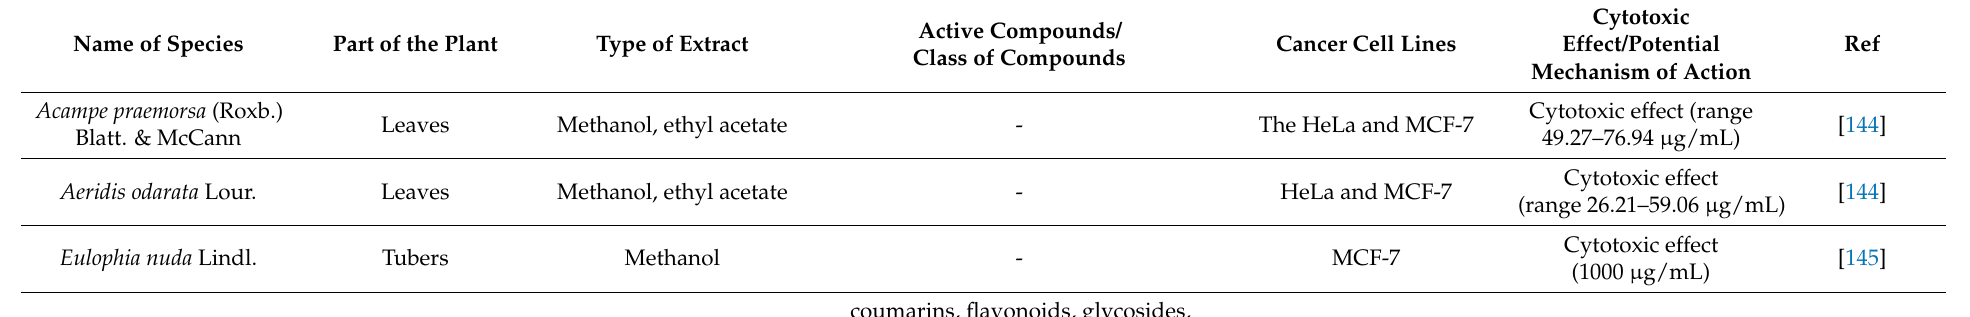
Table 1. Cytotoxic effect and potential mechanism of action of Orchid